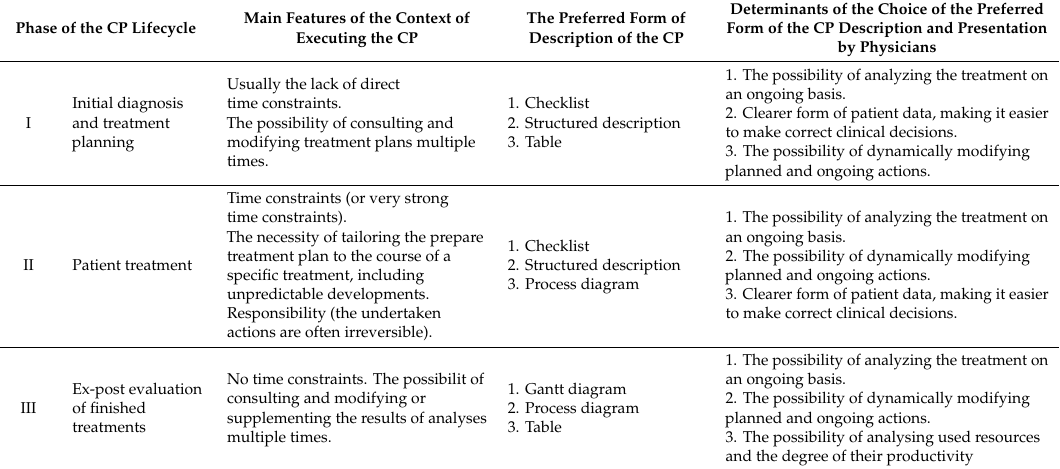
Table 4. Variability of the main features of the context of performance, and the preferred forms of descriptions, at di ff erent phases of the